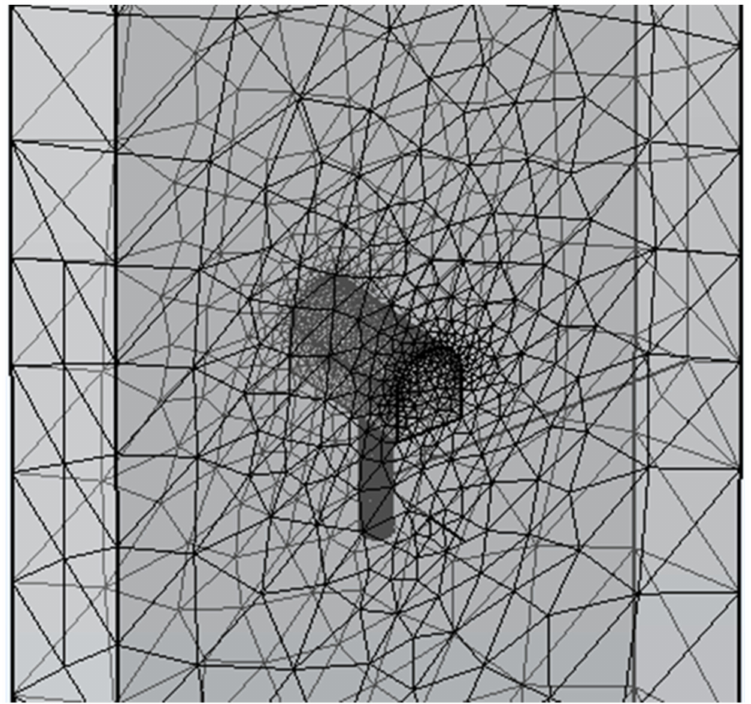
Figure 3. Finite element mesh for EBS and host